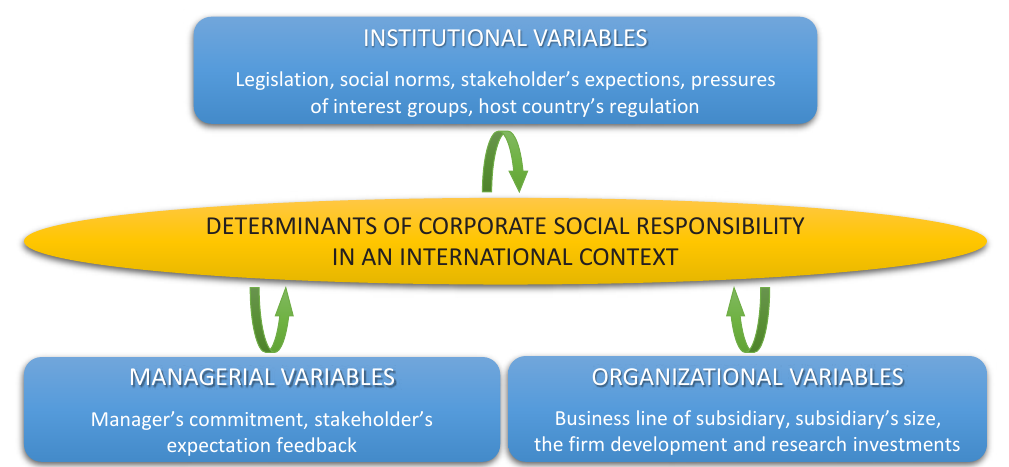
Figure 2. Determinants of c CSR practices case of multinational companies. Personal elaboration according to the foundations of Borchani